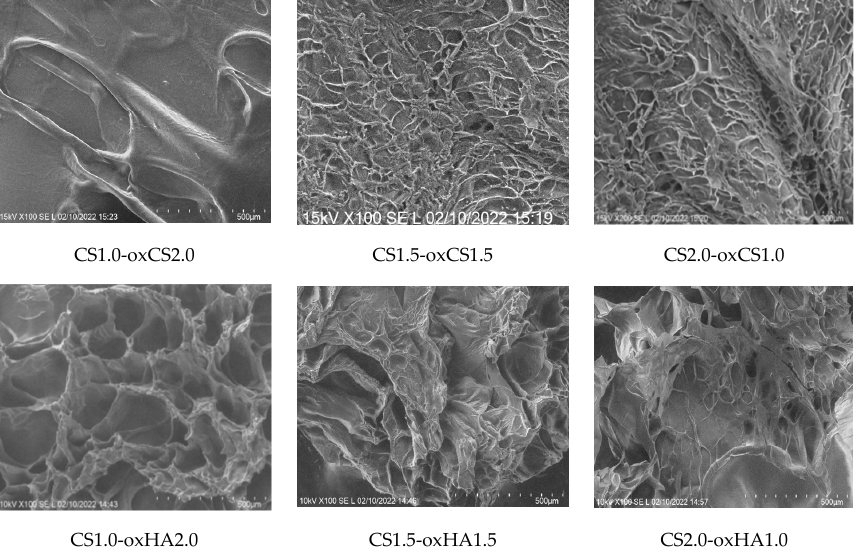
Figure 4. The SEM images of CS-oxCS/oxHA hydrogels.